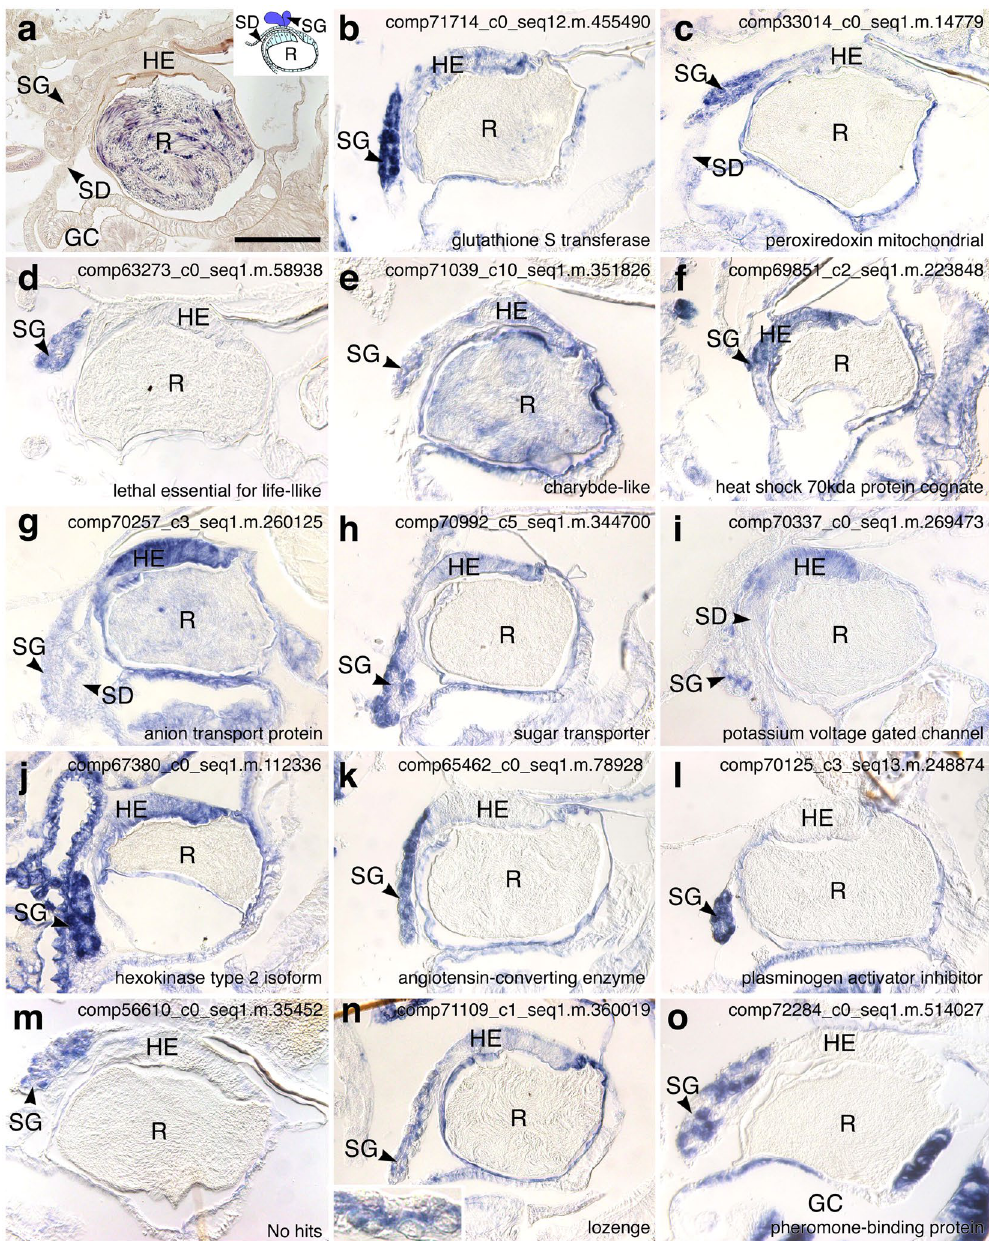
Figure 5. Longitudinal section of the spermatheca stained with hematoxylin and eosin ( a ) and expression patterns of selected highly expressed contigs in the spermatheca ( b – o ). Schematic indications of spermatheca morphology are shown in the upper right corner ( a ). Details of the spermathecal gland are shown in the bottom left corner ( n ). Scale bar, 100 µ m; GC, genital chamber; HE, hilar columnar epithelium of the spermathecal reservoir; R, reservoir; SD, spermathecal duct; SG, spermathecal